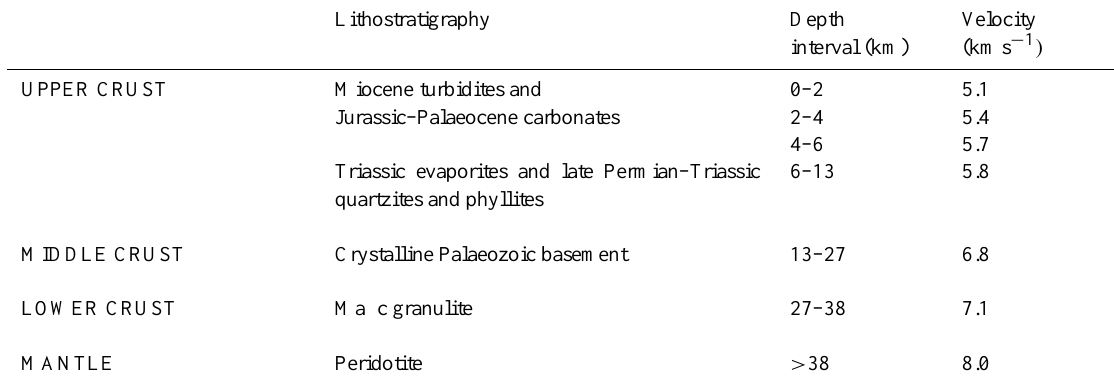
Table 2. The best 1-D velocity model estimated for the Sulmona area and its inferred composition